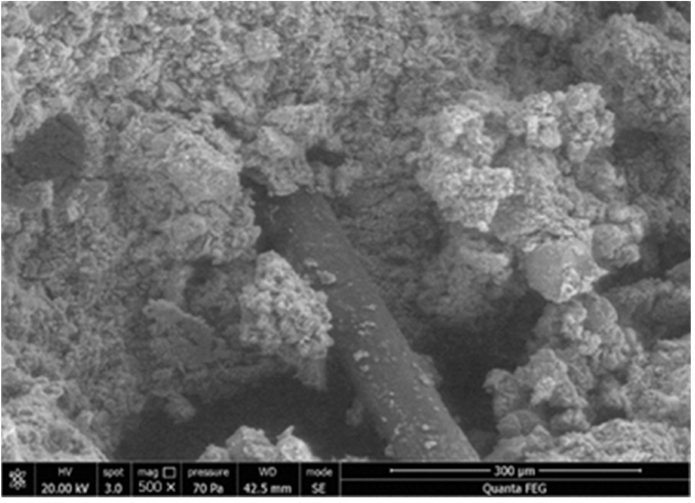
Figure 11. Microstructure of UCS fracture